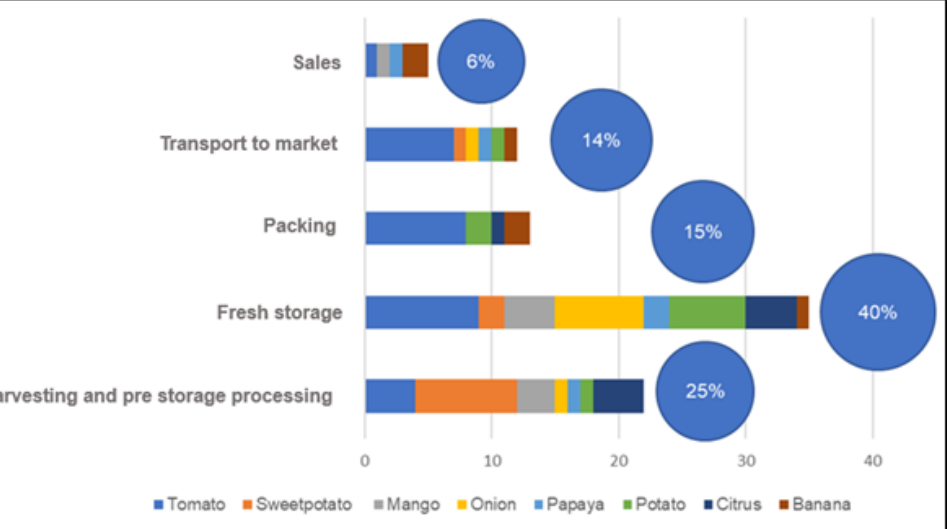
Figure 1. Number of studies on fruit and vegetable loss reduction in Sub-Saharan Africa by areas of